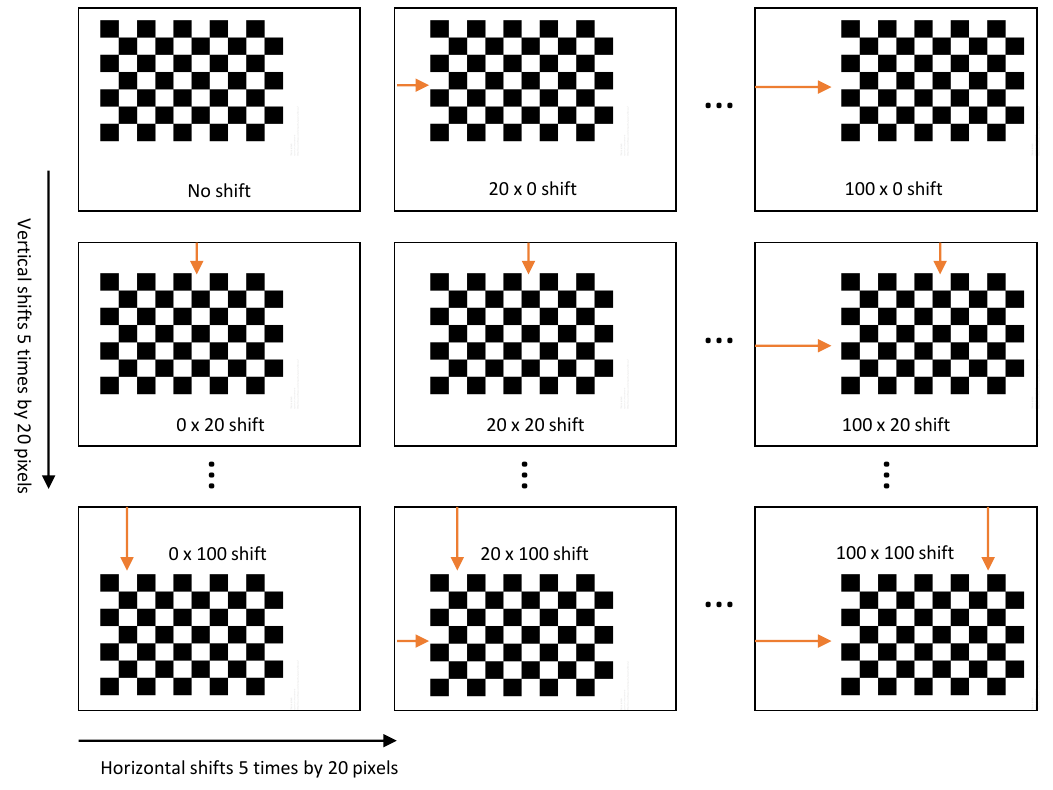
Figure 4. An example of generating chessboard patterns with 25 different positions. Our calibration system projects the chessboard pattern by moving 5 times by 20 pixels in both the horizontal and vertical directions so that a total of 1350 samples can be gathered in this